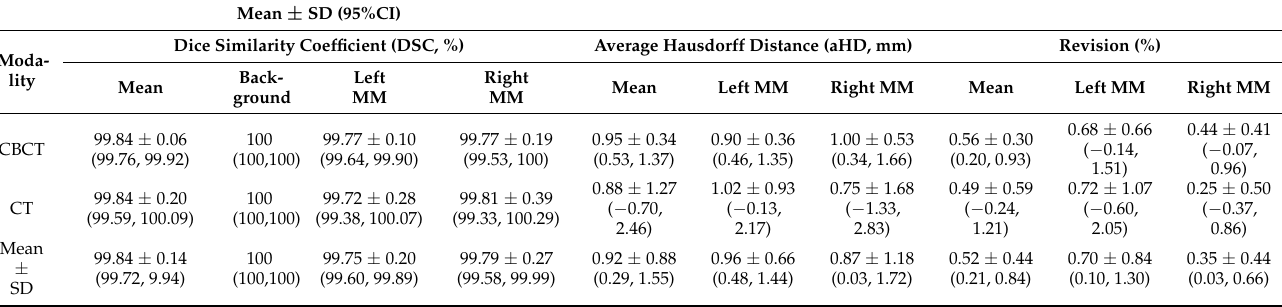
Table 5. The DSC (%) and aHD (mm) of five CBCT and five CT images and the fraction of manual correction (%) between the original auto-segmentations and expert-revised